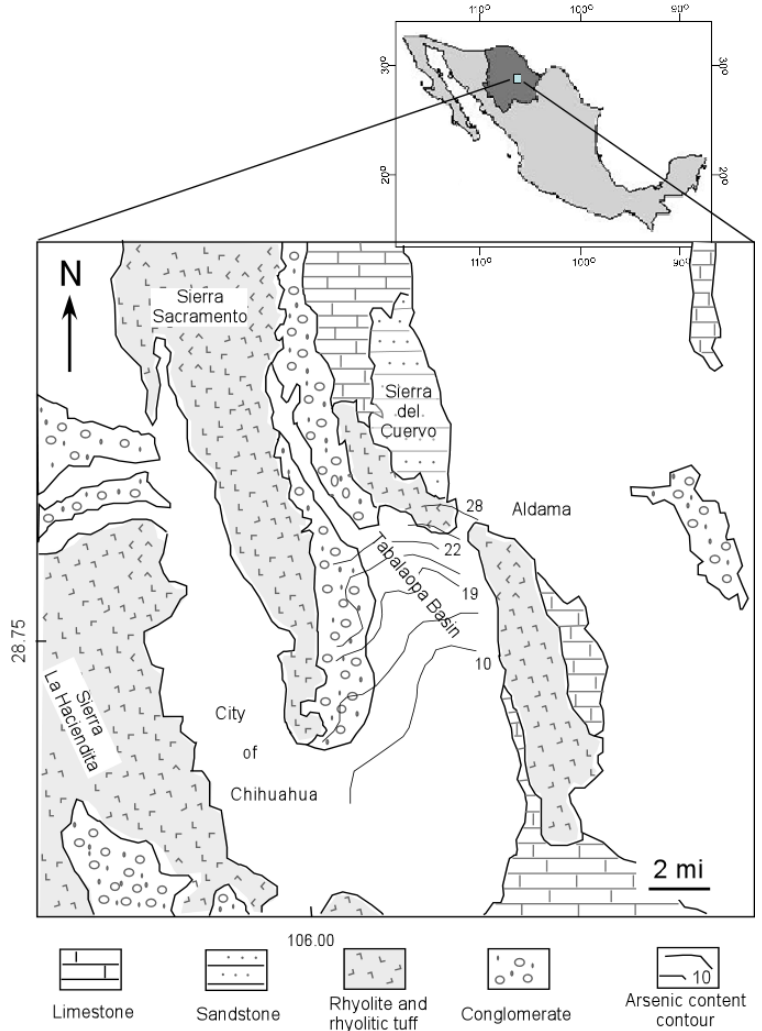
Figure 1. Simplified geological map of the studied area (modified from Carta Geologica de la Re- publica Mexicana [9]). Arsenic contour is based on the arsenic content in the wells (not indicated in this map, data, from Rodríguez- Pineda (2000) [7], plot by software “Surfer” with Kriging interpolation method).